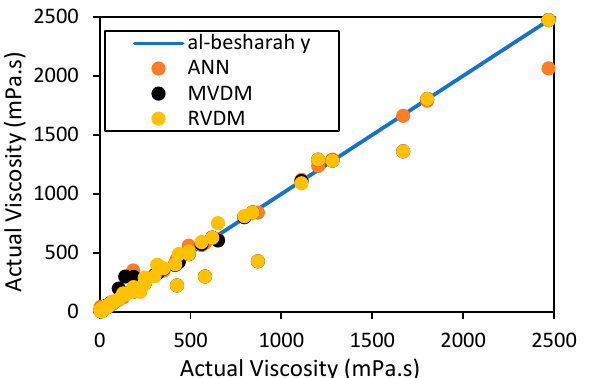
Figure 9. Comparison of the ANN- and empirical-model-predicted values to the literature data. For reference purposes, the ANN regression plots for the experimental and Al- Besharah data are presented in Figures 10 and 11, respectively.